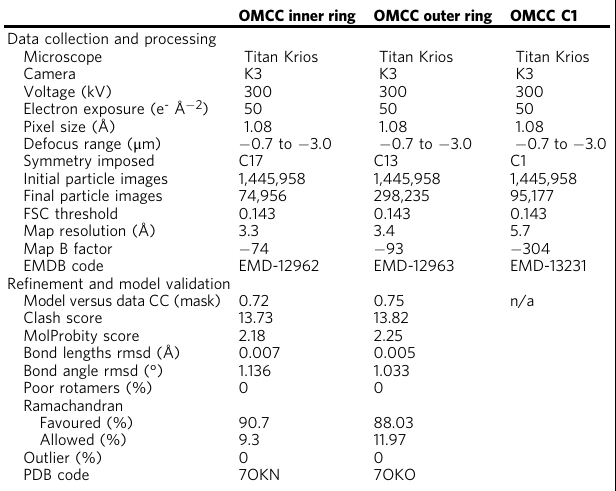
Table 1 Cryo-EM data collection, processing and model re fi nement